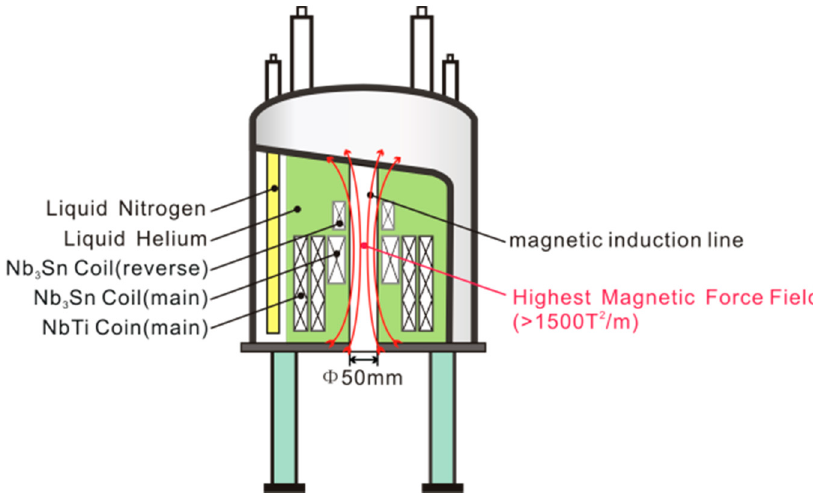
Figure 3. Schematic diagram of the superconducting magnet (JMTA-16T, JASTEC, Inc.) now installed at Northwestern Polytechnical University, Xi’an, China [11].